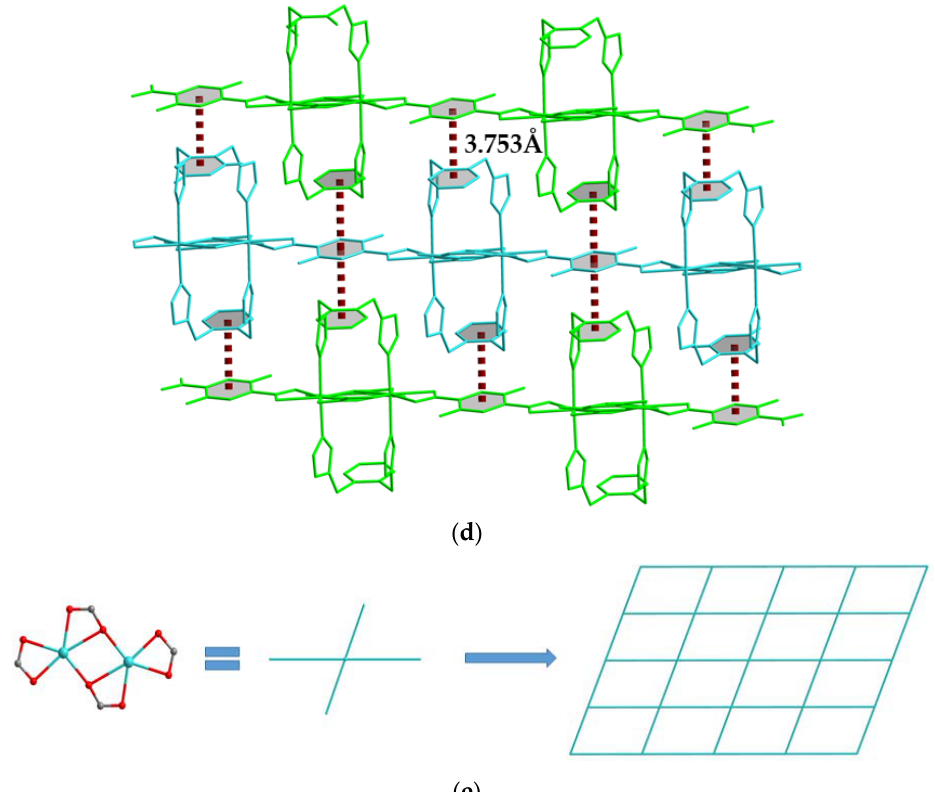
Figure 1. ( a ) The coordination environment of the Zn II ion in complex 1 (symmetry codes: #1 − X, − Y, − Z); ( b ) Two coordination modes of 2,5-dtpa ligand; ( c ) The 2D layered structure; ( d ) The 3D supramolecular structure by π … π interactions; ( e ) The sql topology of the complex 1 (cyan, Zn; blue, N; red, O; gray, C; light blue, H).